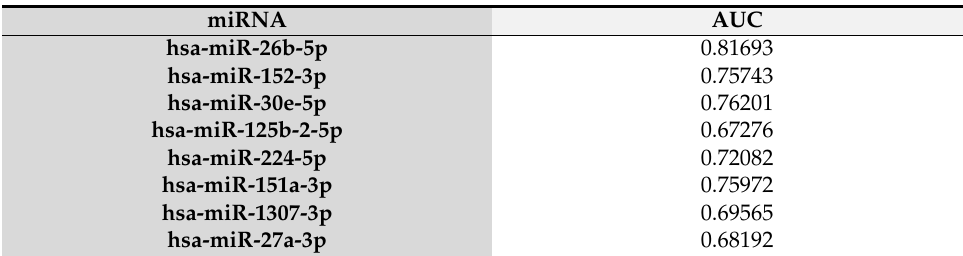
Table 5. Area under the curve for the eight miRNAs with significant differential expression be- tween